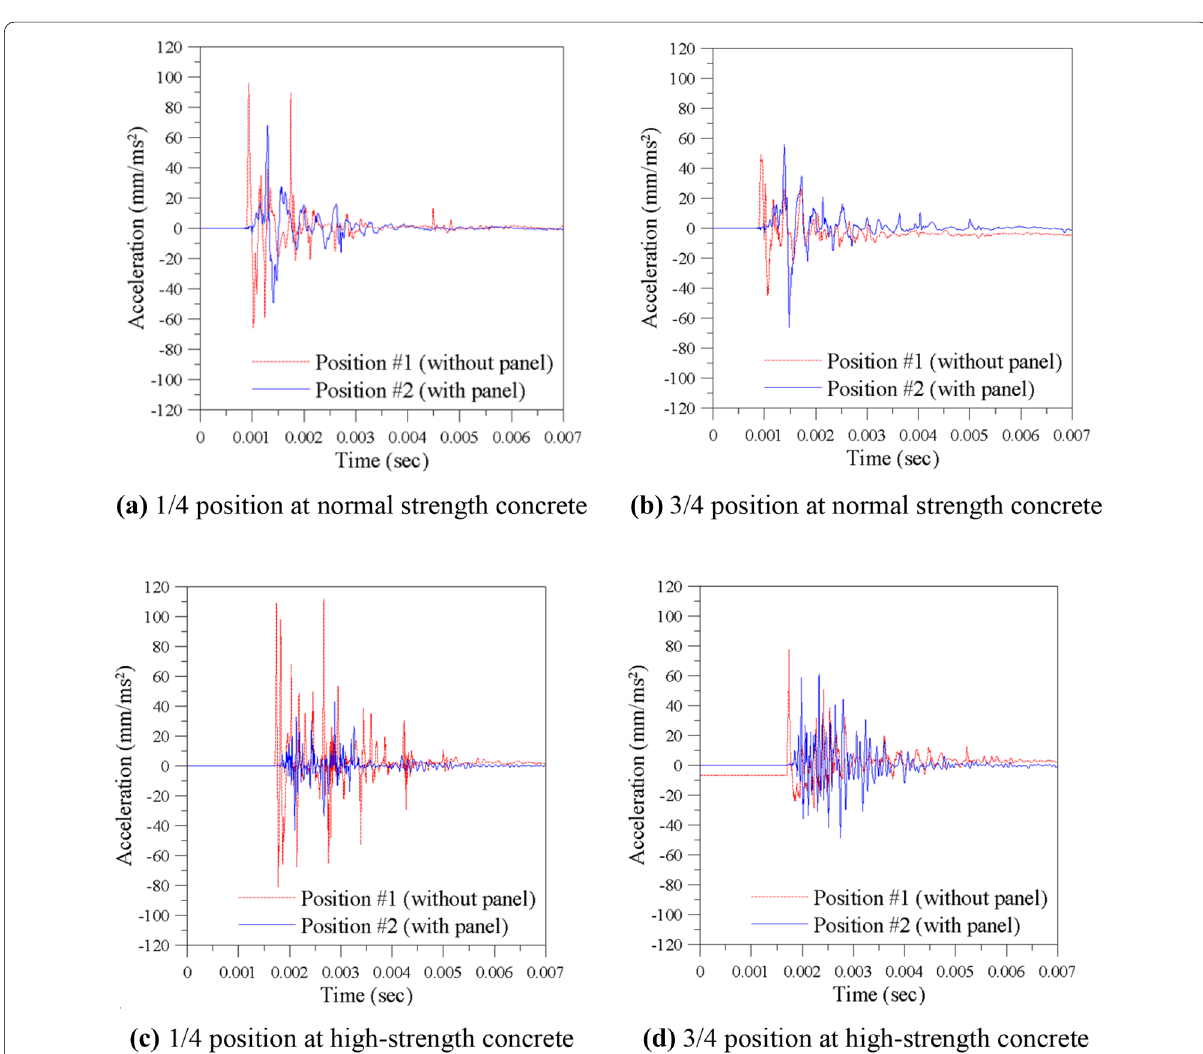
Fig. 14 Acceleration measured at outside wall during in situ explosion experiment.